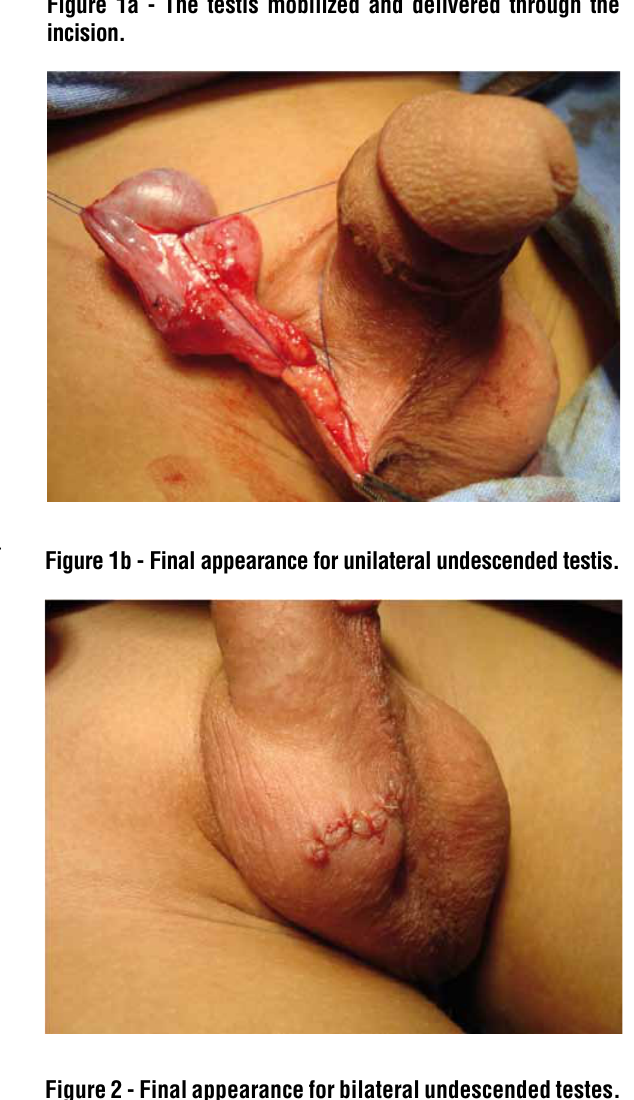
Figure 2 - Final appearance for bilateral undescended